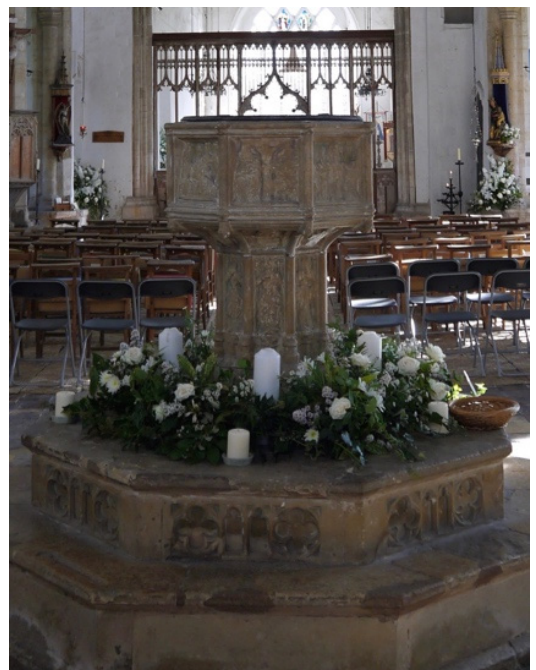
Figure 11. Font at St Mary’s South Creake.